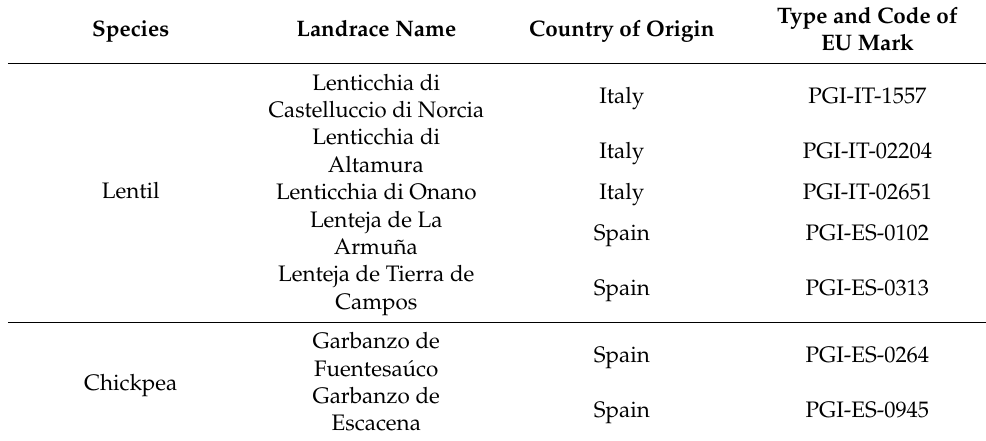
Table 1. List of lentil and chickpea landraces that obtained one European quality